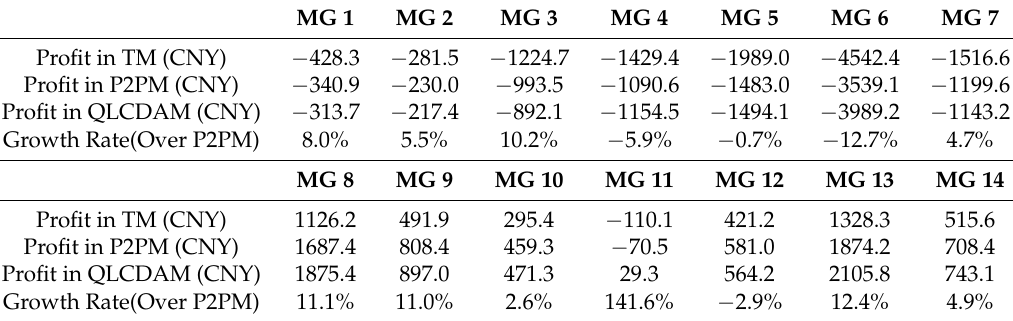
Table 2. Contrast of profits among three energy trading mechanisms 1